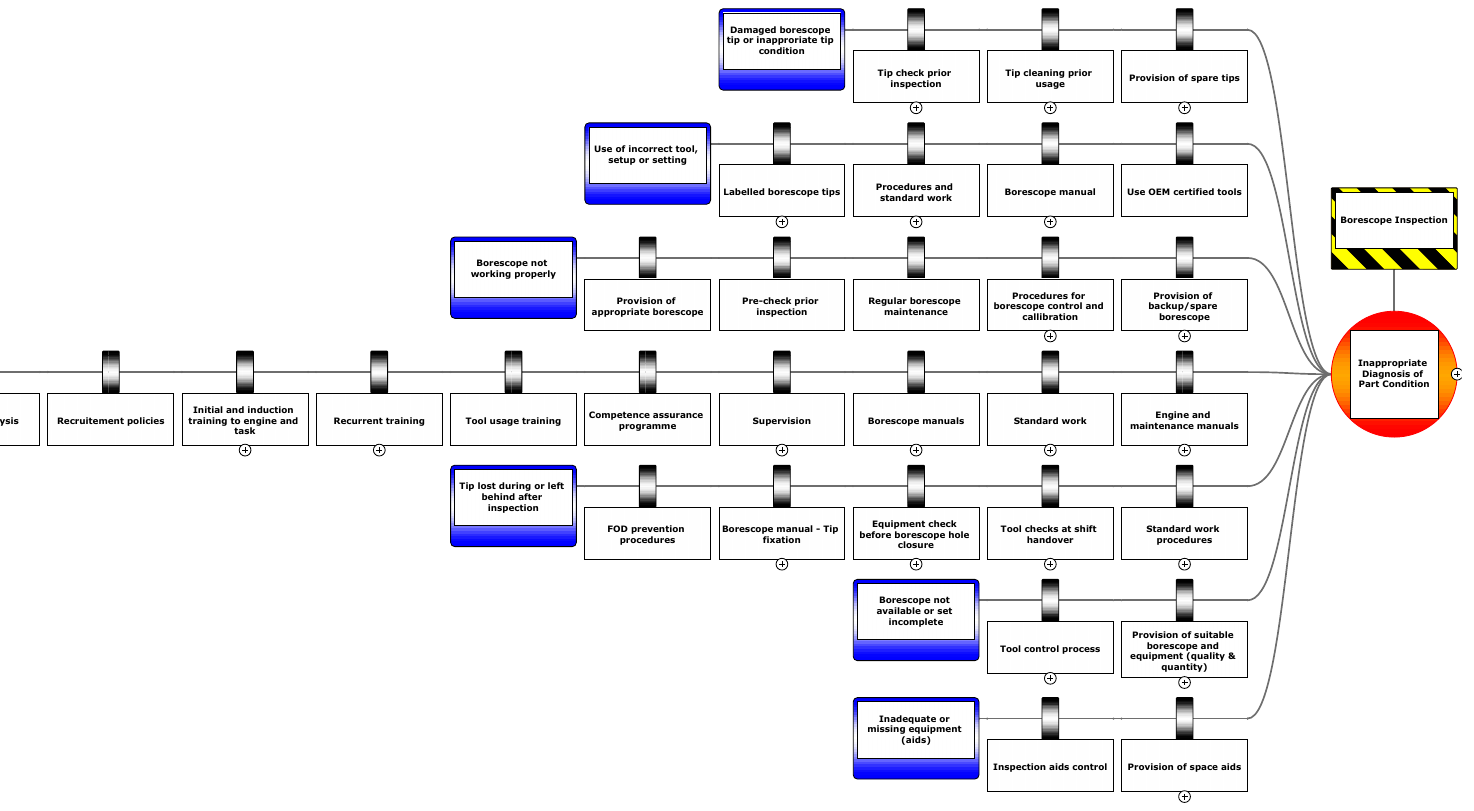
Figure A1. Threat side of the Bowtie diagram with prevention barriers.